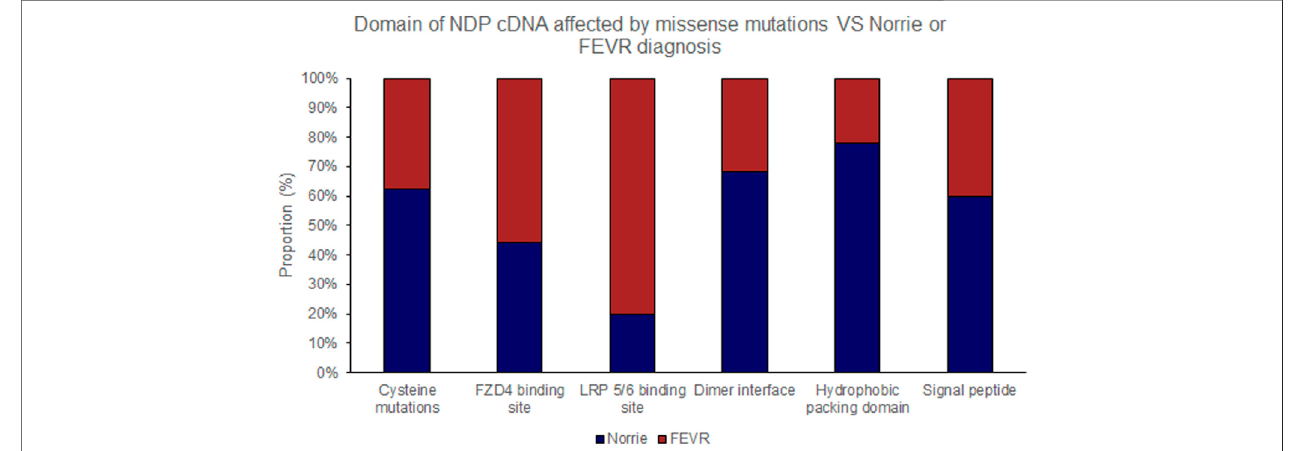
FIGURE 5 | Missense mutations within the NDP coding DNA were classi fi ed by the functional region of the NDP protein affected. The proportion of mutations of each type that causes either Norrie disease or FEVR, as labelled by the authors of each case report, is shown.